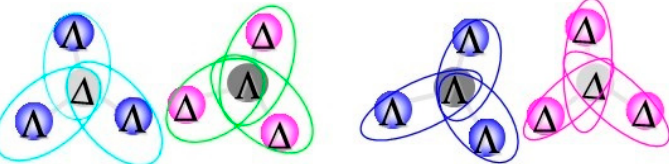
Figure 1. The time change of the ECD spectrum of a methanol solution containing [{ Λ - Ru(III)(acac) 2 (taet)} 3 Al(III)] at room temperature ( left ) and 0 °C ( right ). The spectra were recorded at 3, 5, 8, 10, 13, and 15 min (upper) and 3, 8, 30 and 50 min (lower) after dissolving the solid.